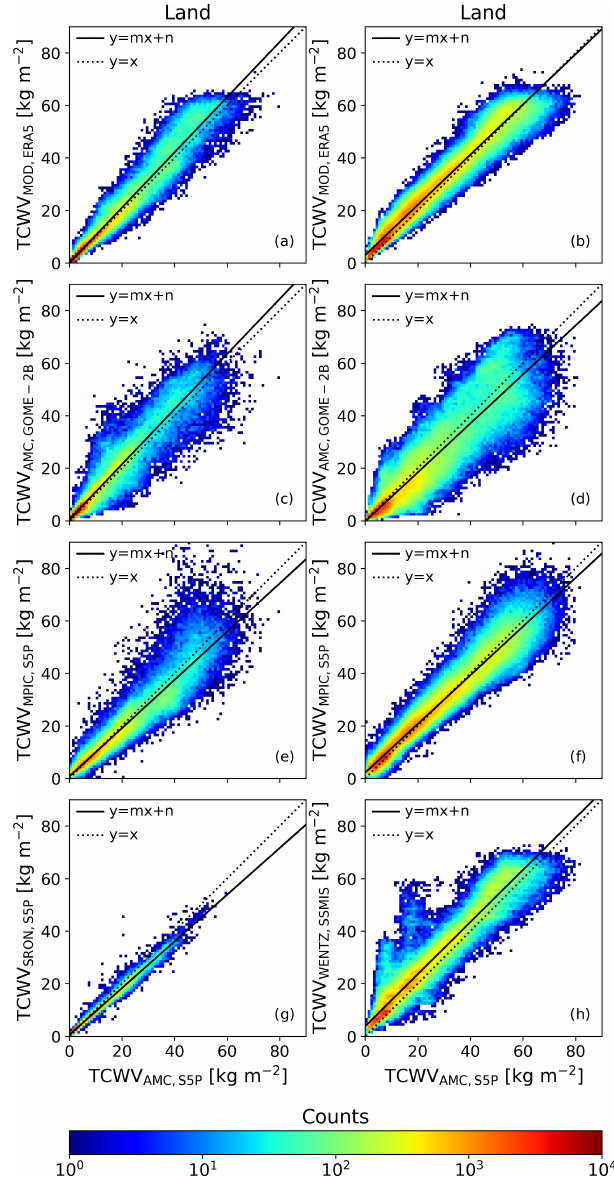
Figure 6. Density plots of TCWV comparisons with the AMC- DOAS S5P product over land (a, c, e, g) and over sea (b, d, f, h) for 23 February 2020 for (a) and (b) ERA5 TCWV, (c) and (d) AMC-DOAS GOME-2B TCWV, (e) and (f) MPIC S5P TCWV, (g) SRON S5P TCWV and (h) SSMIS TCWV. The dotted line repre- sents perfect agreement (1 : 1), and the solid line shows the (fitted) linear relationship between the data sets. All statistical parameters are given in Table